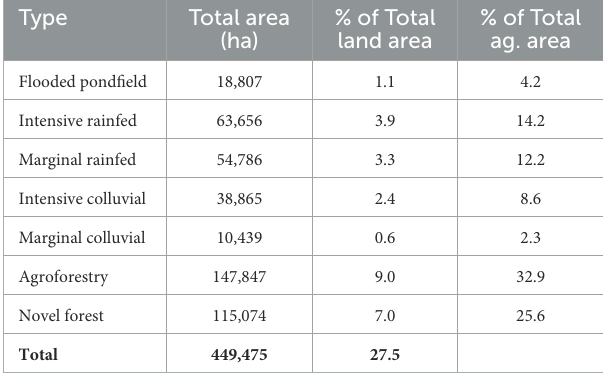
TABLE 2 Modeled area in hectares and associated percentages of each agroecological